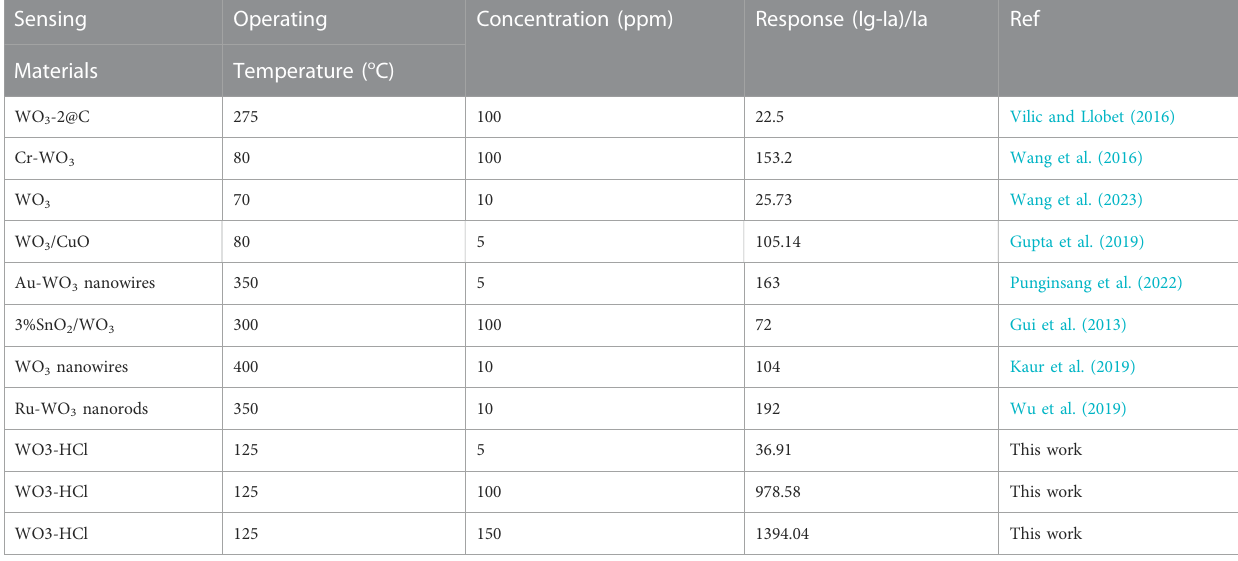
TABLE 2 Comparison of hydrogen sulphide (H 2 S) gas sensing performance of WO 3 -HCl based sensor with other sensing materials in previous reports.